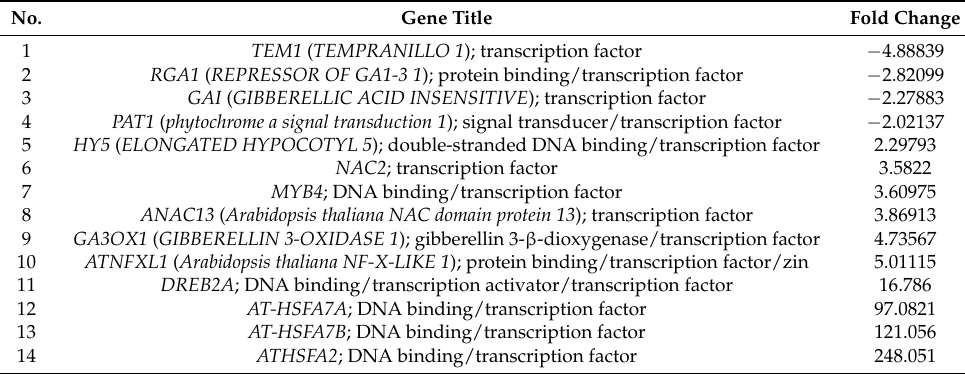
Table 1. Transcription factors of light signaling pathways involved in heat stress response (positive “Fold Change” means upregulated after HS; negative means downregulated). These TFs (transcription factors) indicate that light signaling pathways also respond to HS to some extent.